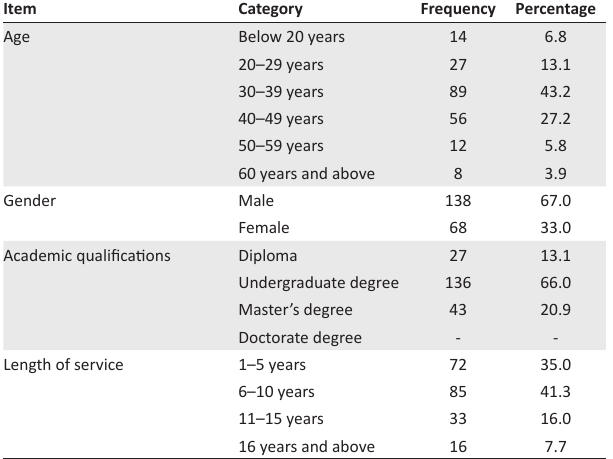
TABLE 2: Demographic characteristics of the respondents. Item